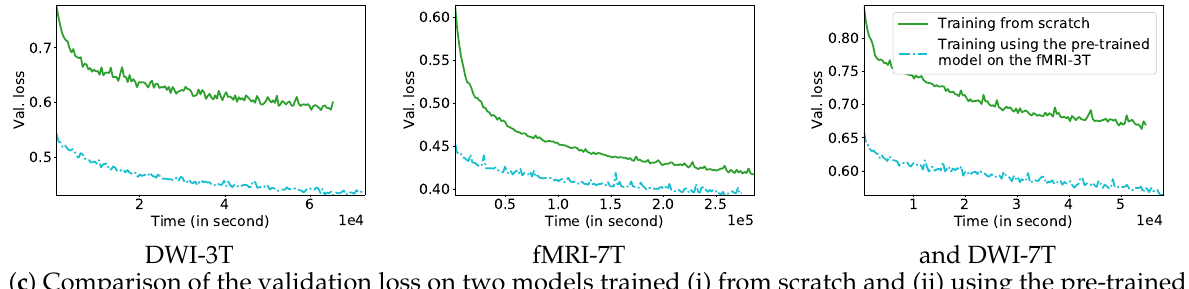
( c ) Comparison of the validation loss on two models trained (i) from scratch and (ii) using the pre-trained model of the fMRI-3T dataset. Figure 4. Ablation study of TS-Net in terms of ( a ) network configurations, ( b ) the 3D distortion model and anatomical guidance, and ( c ) using a pre-trained model. Plots show the validation loss of trained models versus training time (in